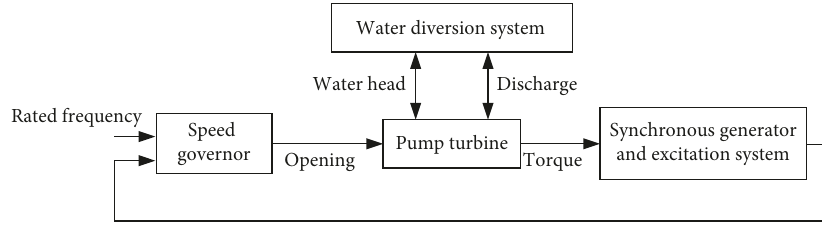
Figure 1: Structure of